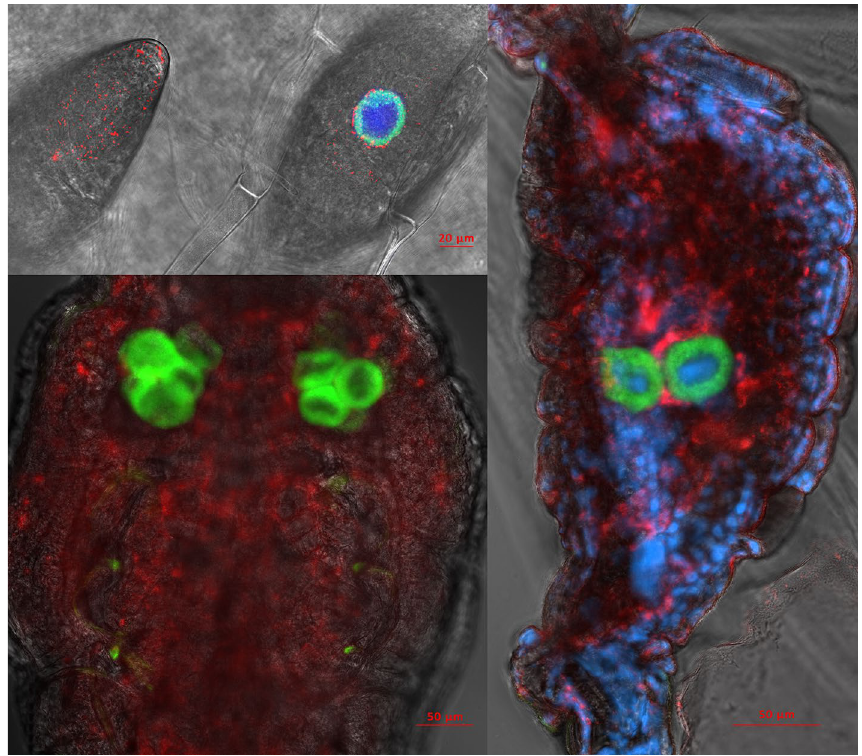
Figure 1. Localization of endosymbionts Portiera (green) and Rickettsia (red) in whitefly eggs (top left), nymphs (bottom left), and adult abdomen (right) using fluorescence in situ hybridization with DAPI nucleic acid counterstain (blue). DAPI was not used in the nymph sample. The background grayscale image shows the transmitted light acquired using the transmitted photomultiplier tube (tPMT)